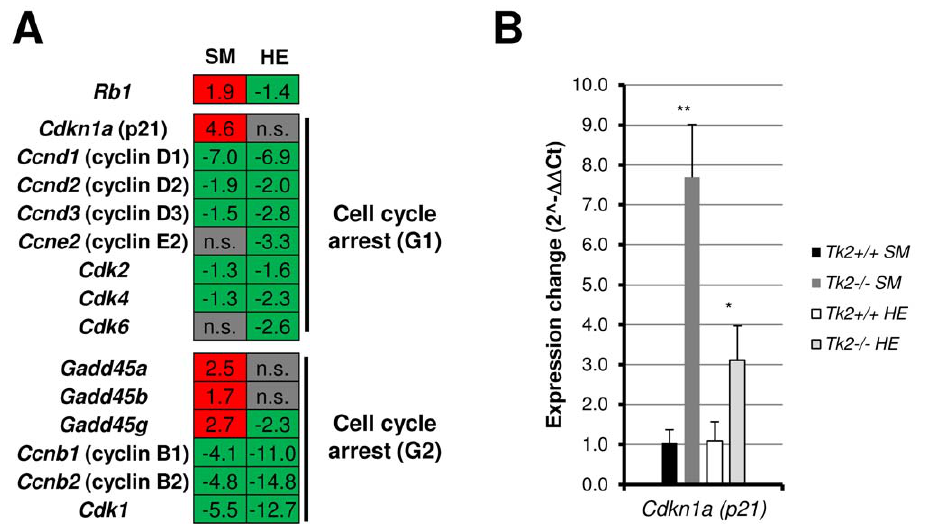
Figure 3. Gene expression variation of some genes involved in cell cycle arrest in both skeletal muscle and heart of 11 days-old Tk2 knockout ( Tk2 2 / 2 ) mice. A ) Expression values obtained in the microarray analysis for some genes involved in cell cycle arrest at G1 or G2. SM and HE refer to each of the gene expression analyses made, in skeletal muscle and in heart. n.s. indicates that the gene is not significantly up- or down- regulated in the analysis. B ) Expression of Cdkn1a (p21) was also analysed by Real-time qPCR for both tissues. The P -values for statistical comparisons (two-tailed unpaired Student’s t-test) between Tk2 + / + and Tk2 2 / 2 tissues are shown - * P , 0.05; ** P , 0.01.